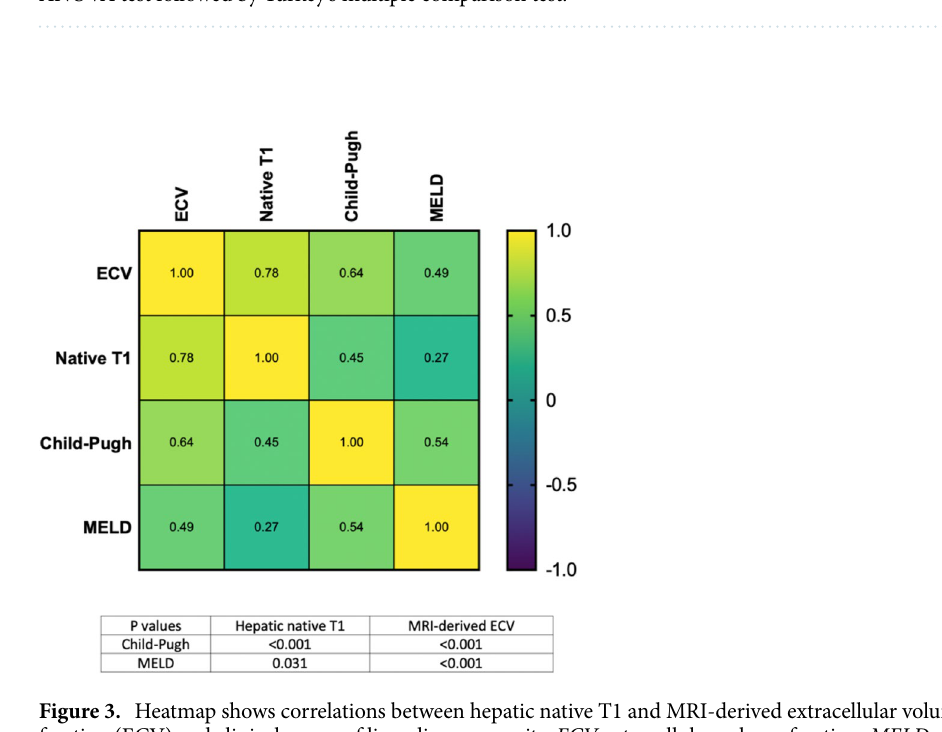
Figure 2. Column graphs with values distribution of hepatic native T1 ( a ) and MRI-derived extracellular volume fraction ( b ) in the control group and in the clinically subclassified cirrhosis groups (Child–Pugh classes A, B, and C). Mean of data is represented by horizontal line. *, **, ***, **** represents significance levels of pairwise comparisons with P values of ≤ 0.05, ≤ 0.01, ≤ 0.001, ≤ 0.0001respectively. P values were obtained using ANOVA test followed by Turkey’s multiple comparison test.